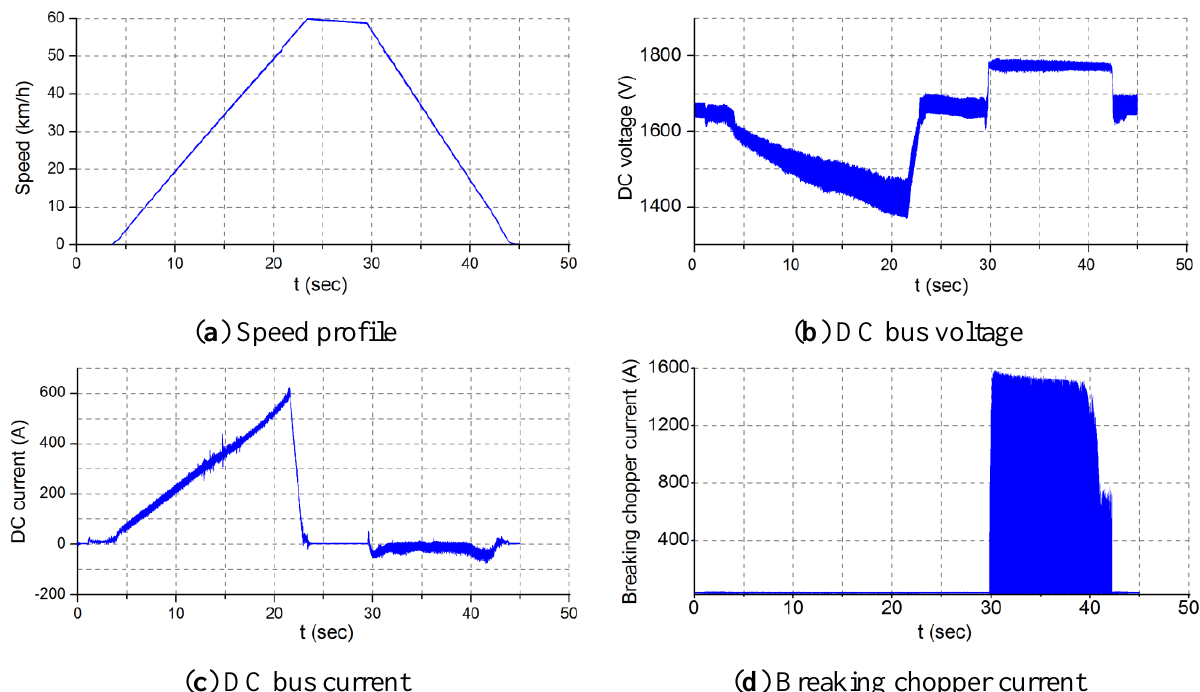
Figure 7. Experiment data of the test metro